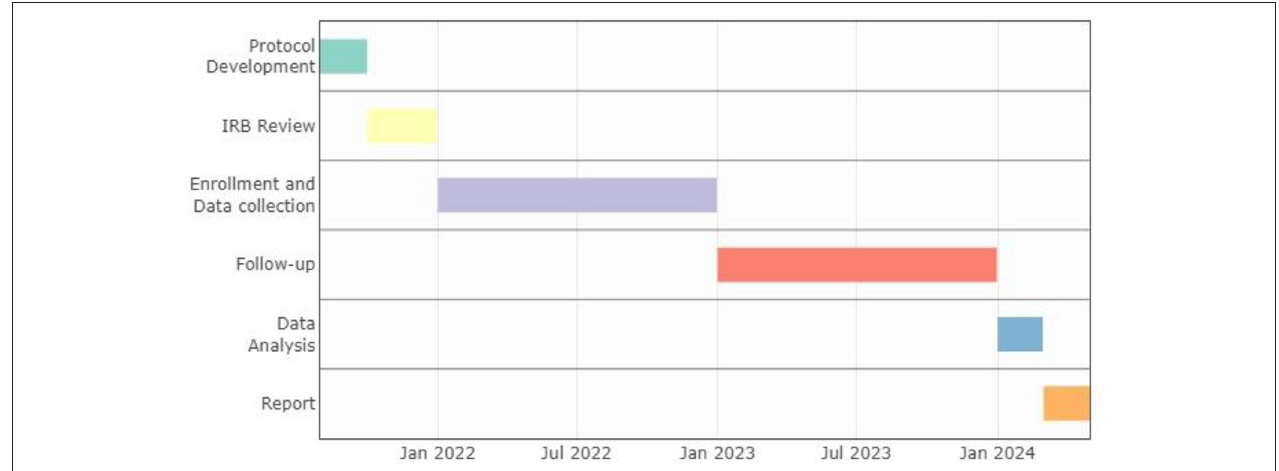
FIGURE 1 | Study timeline and milestones. We use package vistime in RStudio for